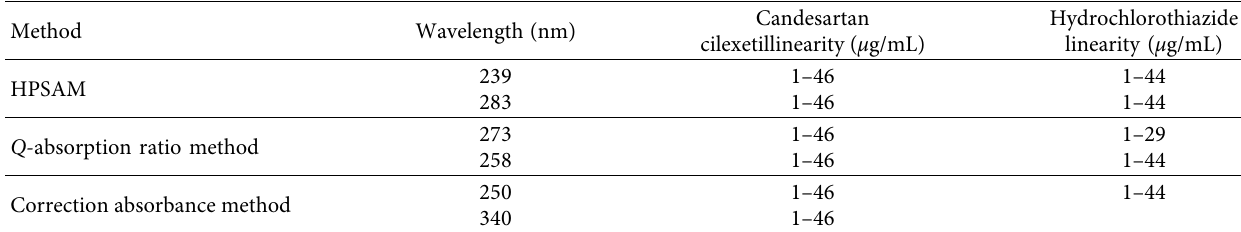
Figure 5: Calibration graph of hydrochlorothiazide at 340, 283, 273, 258, 250, and Table 1: Linearity of drugs at all proposed methods.